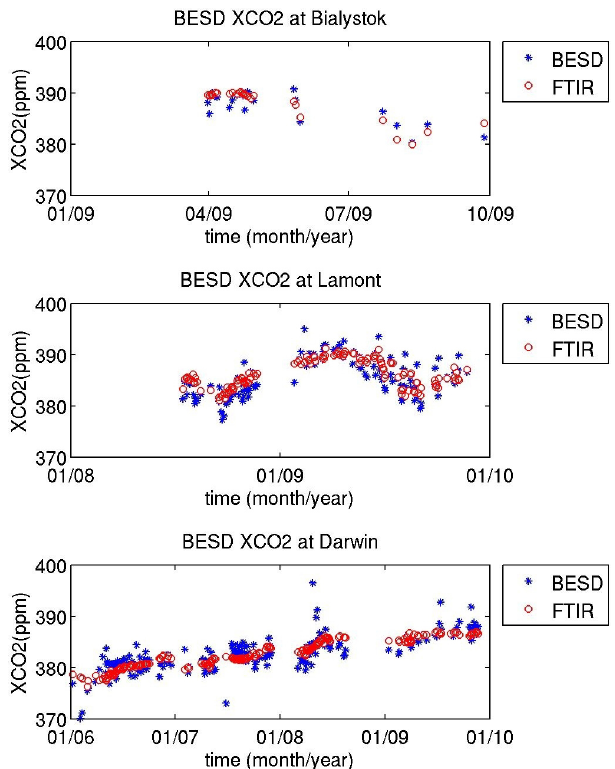
Figure 4. Daily averaged time series of paired BESD and TCCON FTIR XCO 2 at Bialystok (top), Lamont (mid) and Darwin (bottom).